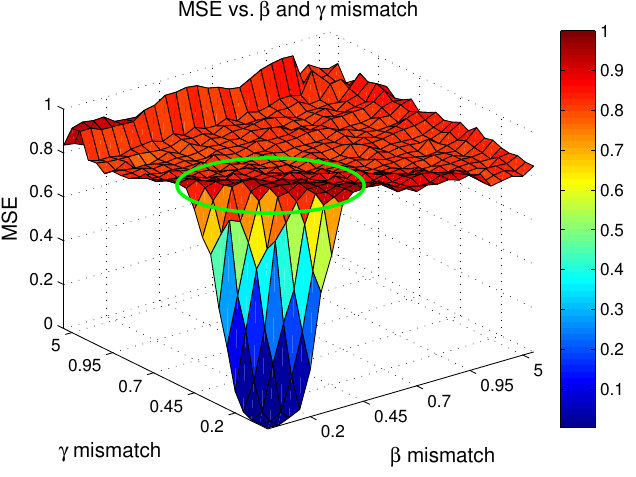
Figure 6. MSE versus β mismatch and γ mismatch. The encircled region shows variation of MSE with fixed β mismatch and varying γ mismatch, and vice